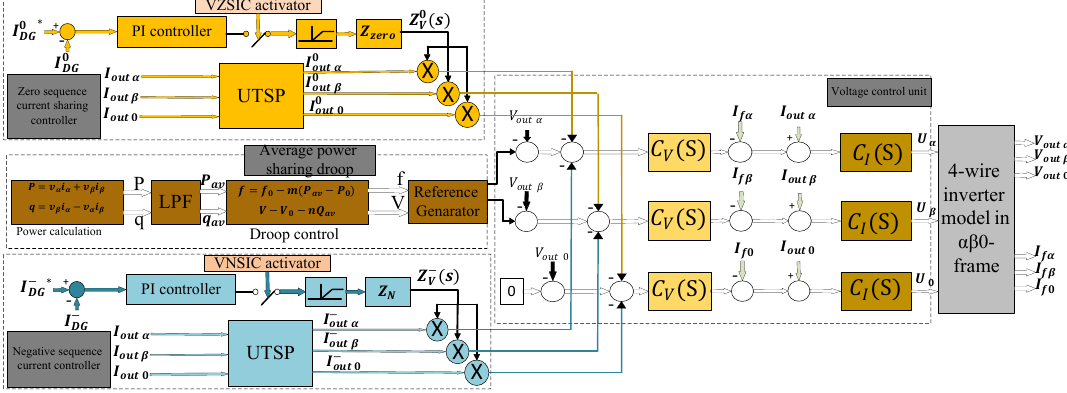
Figure 6. Control structure of DG